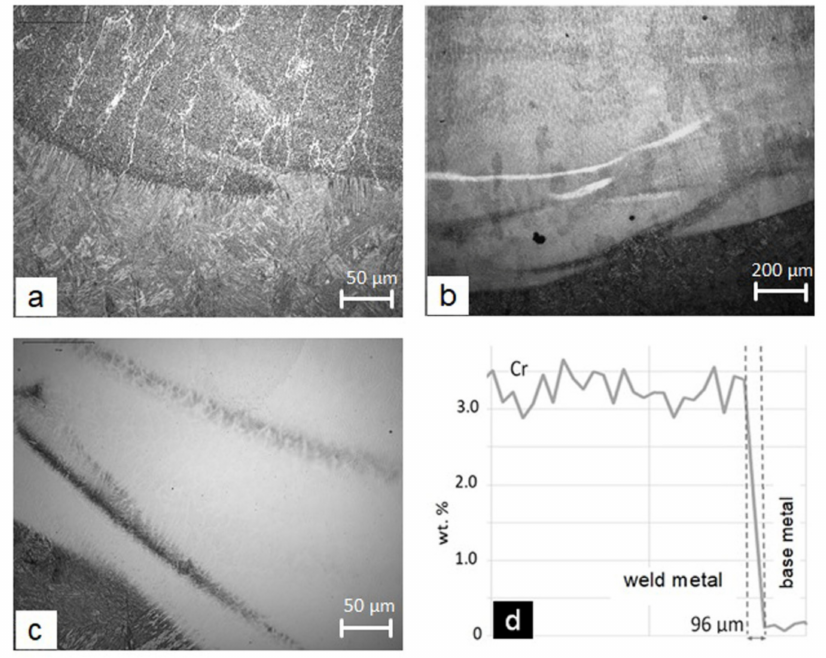
Figure 3. Band-like segregation near the fusion line in surface welds: ( a ) segregations of the S355 steel in the non-alloyed weld no. 1, where columnar crystal grains are also visible (upper half of figure); ( b ) dark segregations of the S355 steel and more alloyed light segregation of the filler materials in the low-alloyed weld no. 2 (the light segregation: Cr = 1.4 wt.%, near the segregation: Cr = 0.66 wt.%); ( c ) dark segregation of the S355 steel in the high-alloyed weld no. 7; ( d ) the distribution of Cr across the fusion line in the weld no. 3, where the partially mixed zone near the fusion line is clearly visible (the width is 96 µ